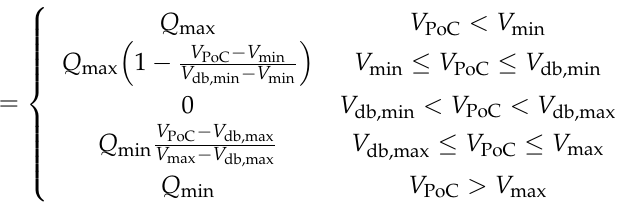
agement strategies.